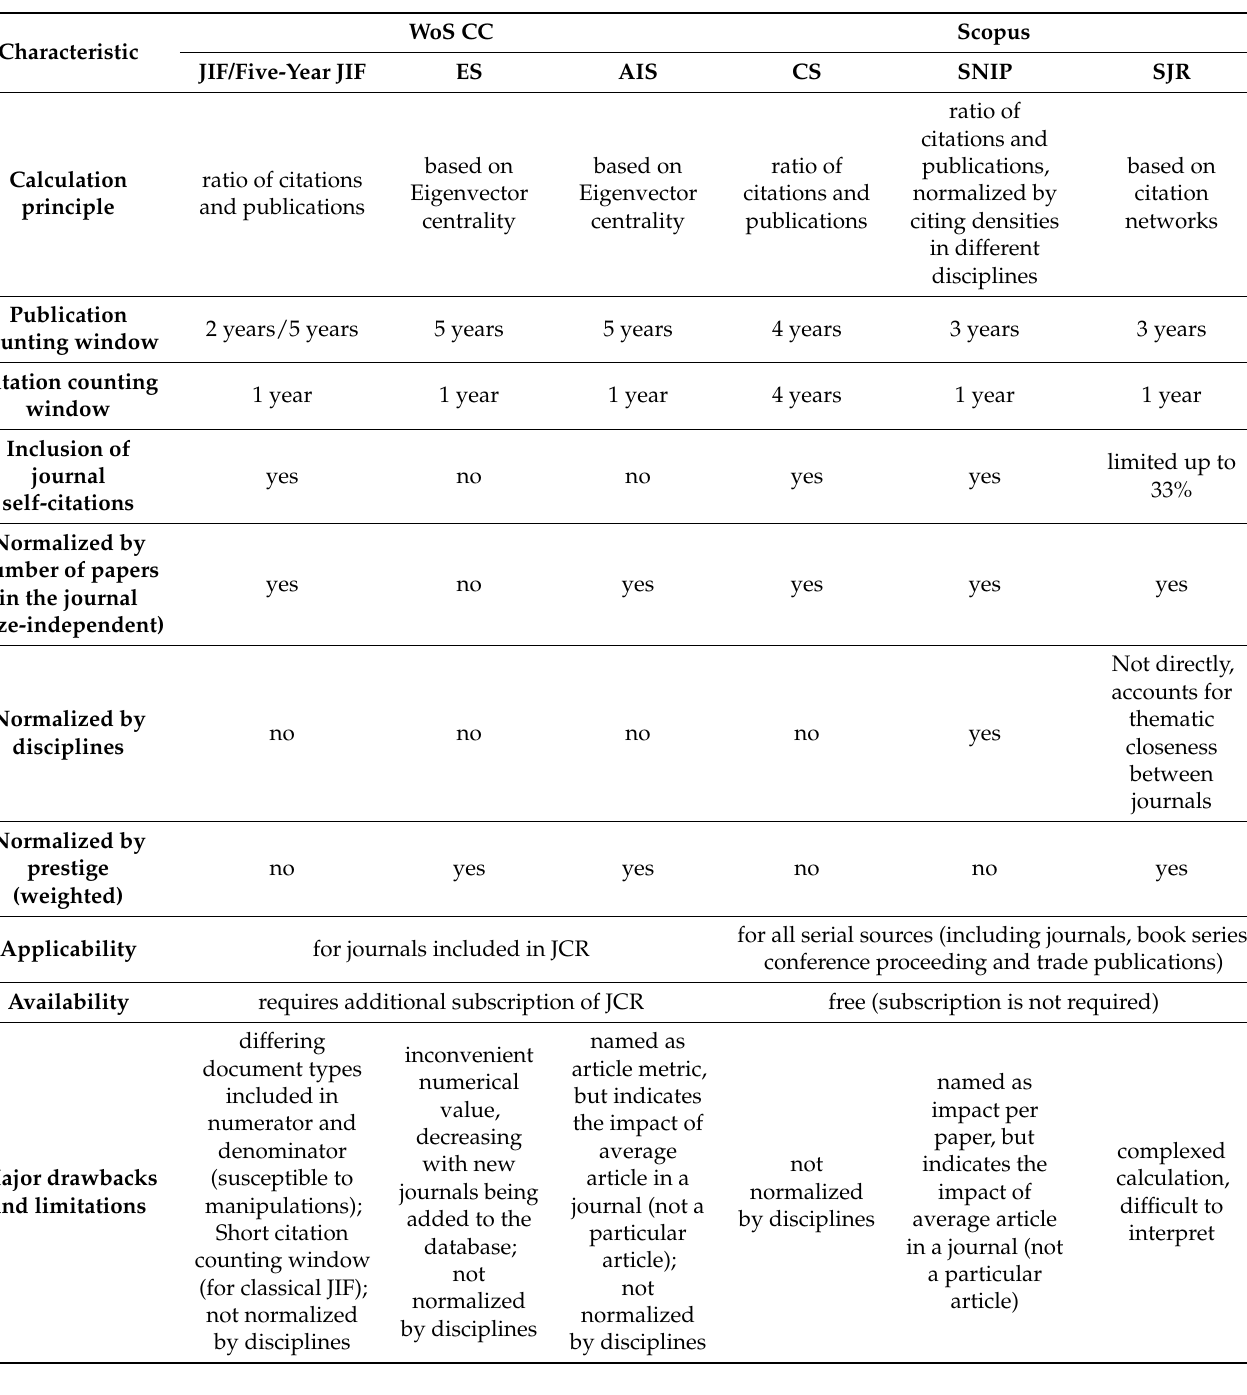
Table 2. Summary of the main features of journal impact indicators provided in WoS and